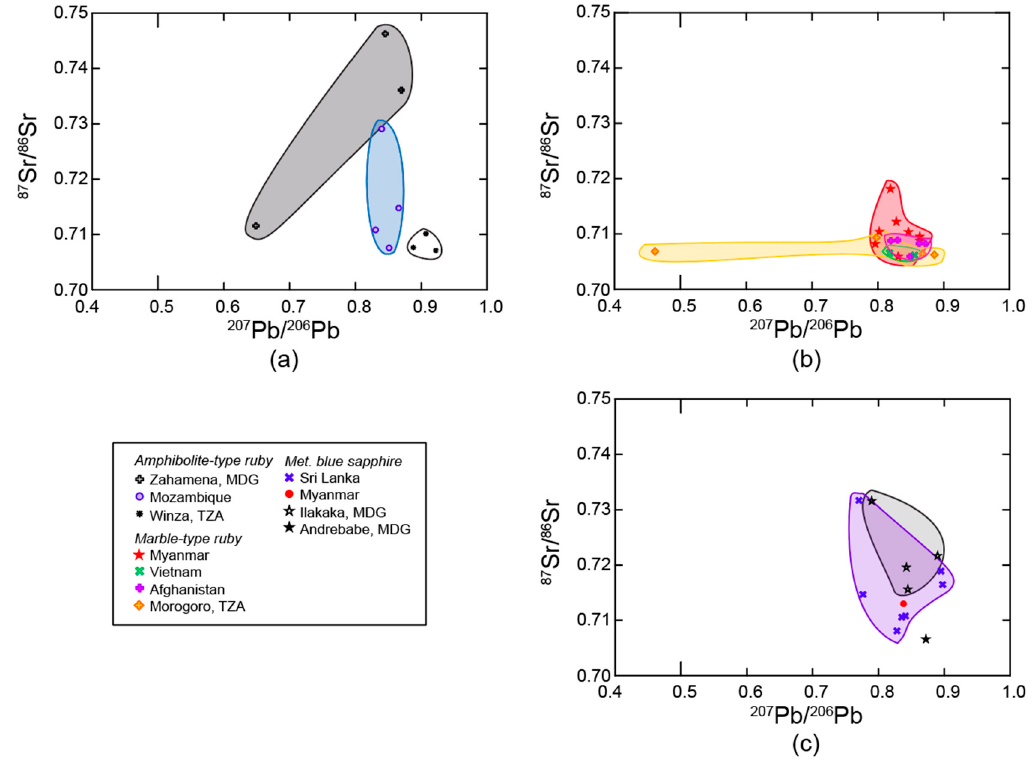
Figure 10. 87 Sr/ 86 Sr vs. 207 Pb/ 206 Pb ratios of ( a ) amphibolite-type rubies, ( b ) marble-type rubies, and ( c ) metamorphic blue sapphires measured in this study. Analytical uncertainties are less than the size of the plot symbols. Color of the fields correspond to the color of the symbols.